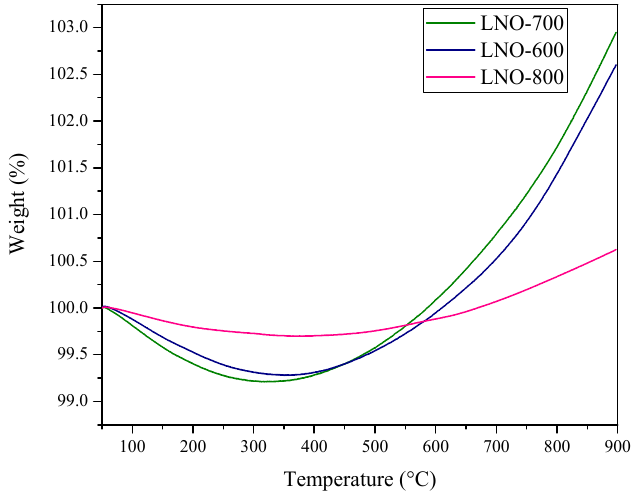
Figure 6. Elucidation of the oxygen vacancies presence in the LaNiO 3 catalysts through thermogravimetric dynamic analysis using an O 2 atmosphere (P O